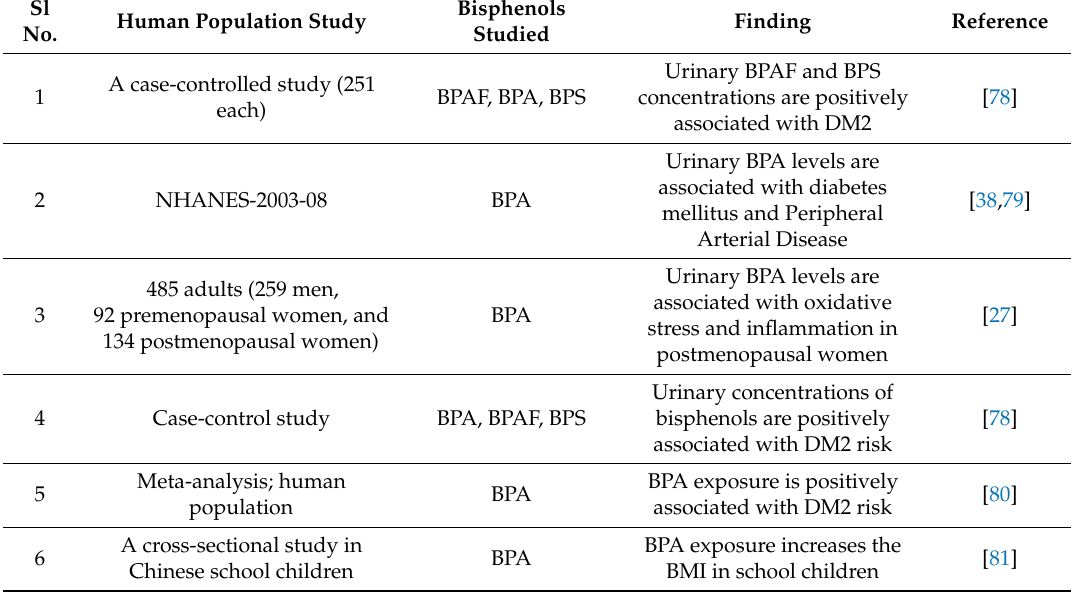
Table 2. E ff ect of bisphenol exposure in the human